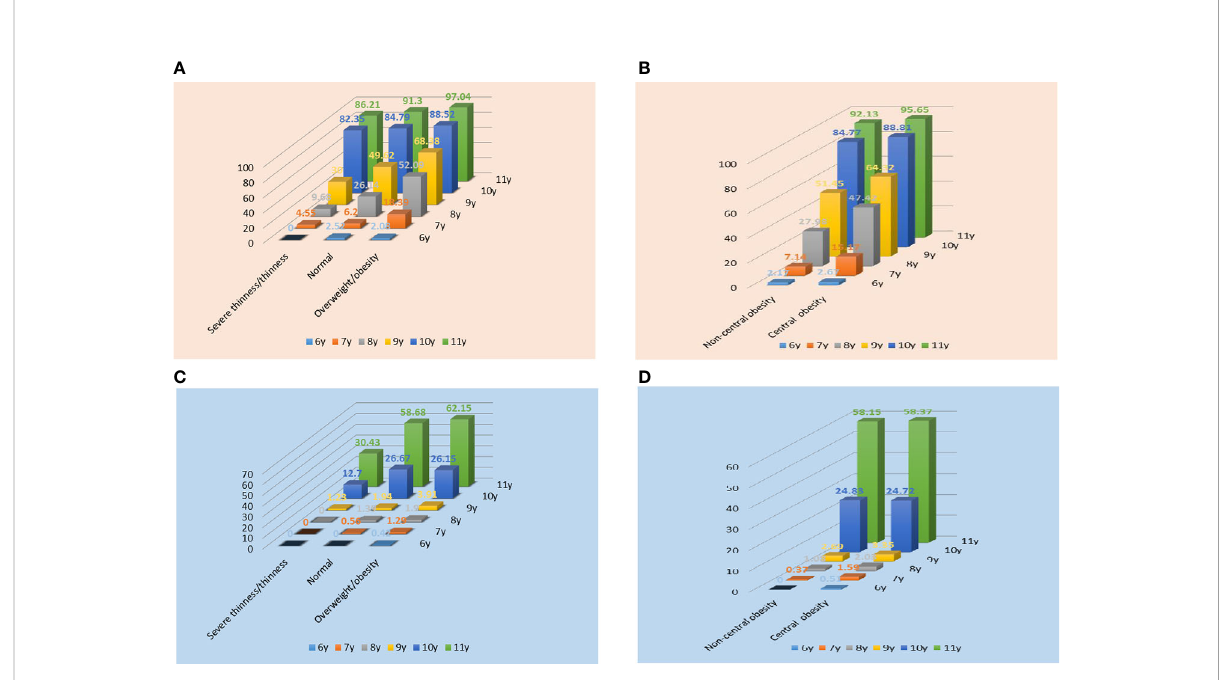
FIGURE 2 Prevalence of Tanner stages ≥ II in different obesity categories in girls (A, B) and boys (C, D) . In Figure A, C, normal refers to children with normal body mass